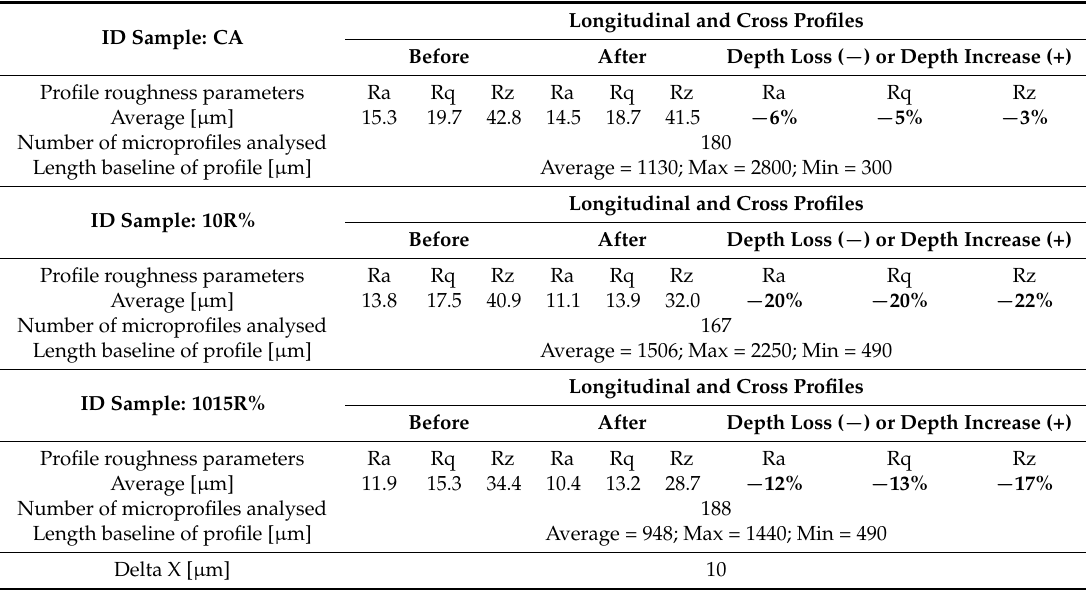
Table 6. Roughness analysis by laser profiles post-processing: roughness parameter values before and after polishing test.